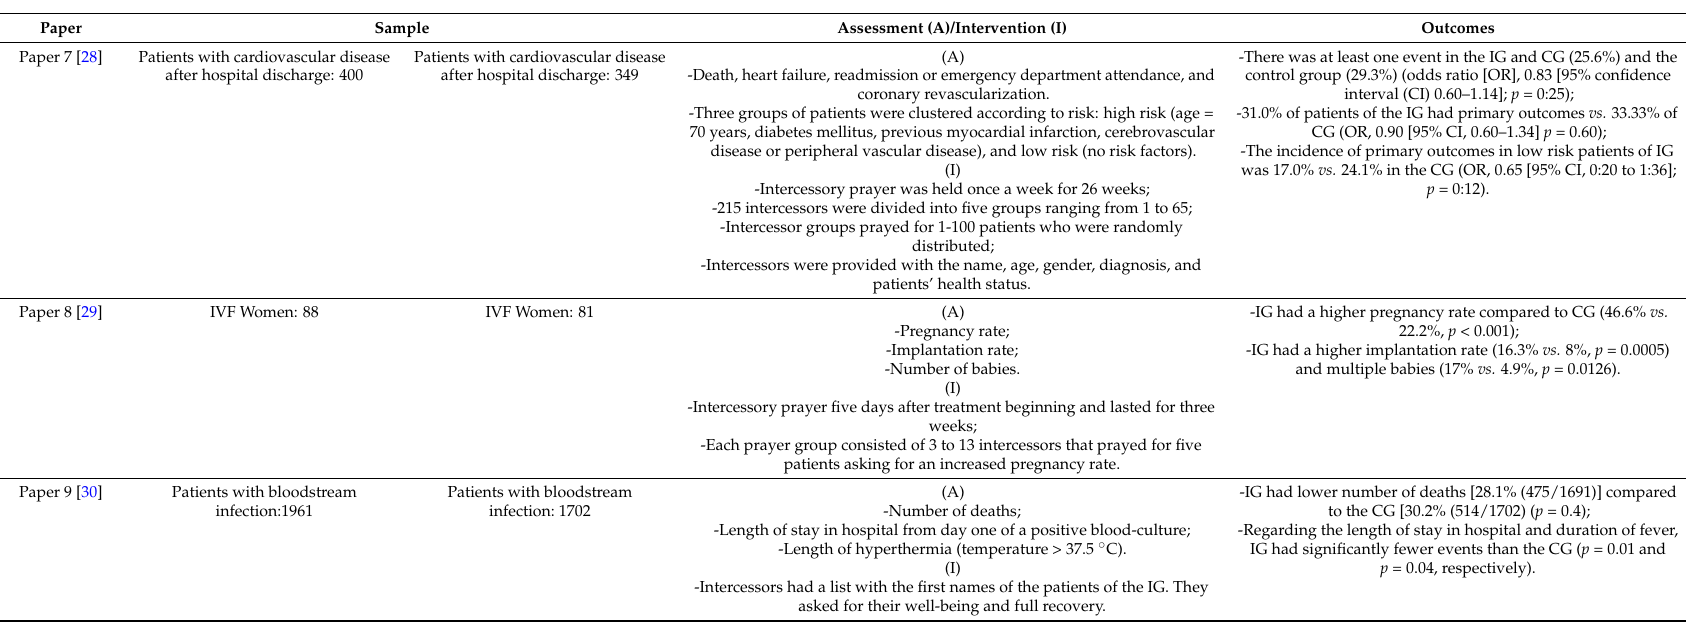
-There was at least one event in the IG and CG (25.6%) and the control group (29.3%) (odds ratio [OR], 0.83 [95% confidence interval (CI) 0.60–1.14]; p = 0:25); -Three groups of patients were clustered according to risk: high risk (age = -31.0% of patients of the IG had primary outcomes vs. 33.33% of 70 years, diabetes mellitus, previous myocardial infarction, cerebrovascular disease or peripheral vascular disease), and low risk (no risk factors). (I) -Intercessory prayer was held once a week for 26 weeks; -215 intercessors were divided into five groups ranging from 1 to 65; -Intercessor groups prayed for 1-100 patients who were randomly distributed; -Intercessors were provided with the name, age, gender, diagnosis, and patients’ health status. -IG had a higher pregnancy rate compared to CG (46.6% vs. 22.2%, p < 0.001); -IG had a higher implantation rate (16.3% vs. 8%, p = 0.0005) -Implantation rate; -Number of babies. and multiple babies (17% vs. 4.9%, p = 0.0126). (I) -Intercessory prayer five days after treatment beginning and lasted for three weeks; -Each prayer group consisted of 3 to 13 intercessors that prayed for five patients asking for an increased pregnancy rate. -IG had lower number of deaths [28.1% (475/1691)] compared to the CG [30.2% (514/1702) ( p = 0.4); -Regarding the length of stay in hospital and duration of fever, IG had significantly fewer events than the CG ( p = 0.01 and p = 0.04, (I) -Intercessors had a list with the first names of the patients of the IG. They asked for their well-being and full recovery.